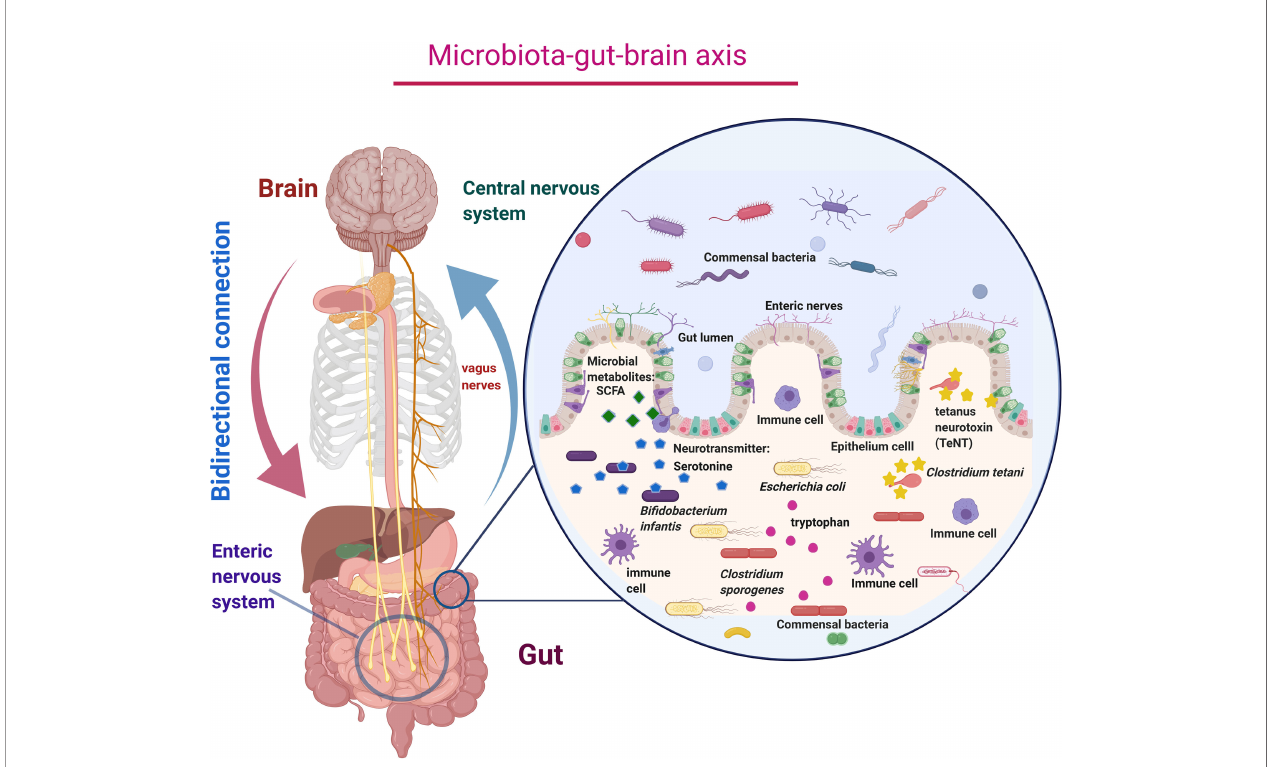
FIGURE 1 | Schematic diagram of microbiota – gut – brain axis represents the bidirectional connection between the central nervous system (CNS) and enteric nervous system (ENS) via the vagus nerves, which carry neurotransmitters like serotonin, tetanus neurotoxin, and microbial metabolites like SCFA produced by the microbial action. Millions of immune cells in the enteric nervous system cause immune-mediated functions and keep healthy microbial